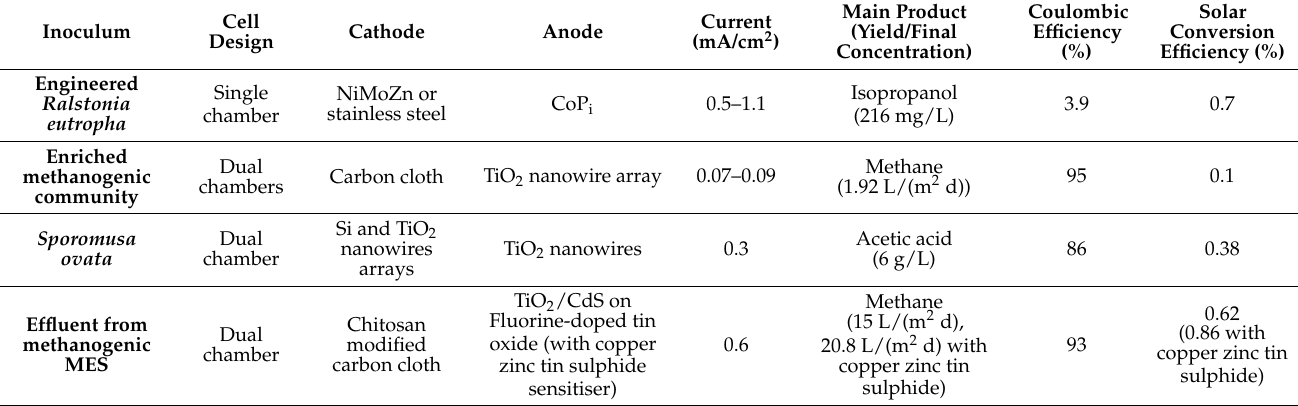
Table 6. Hybrid system devices used in MES for wastewater treatment and CO 2 recycling. Adapted from [8]. Inoculum Cell